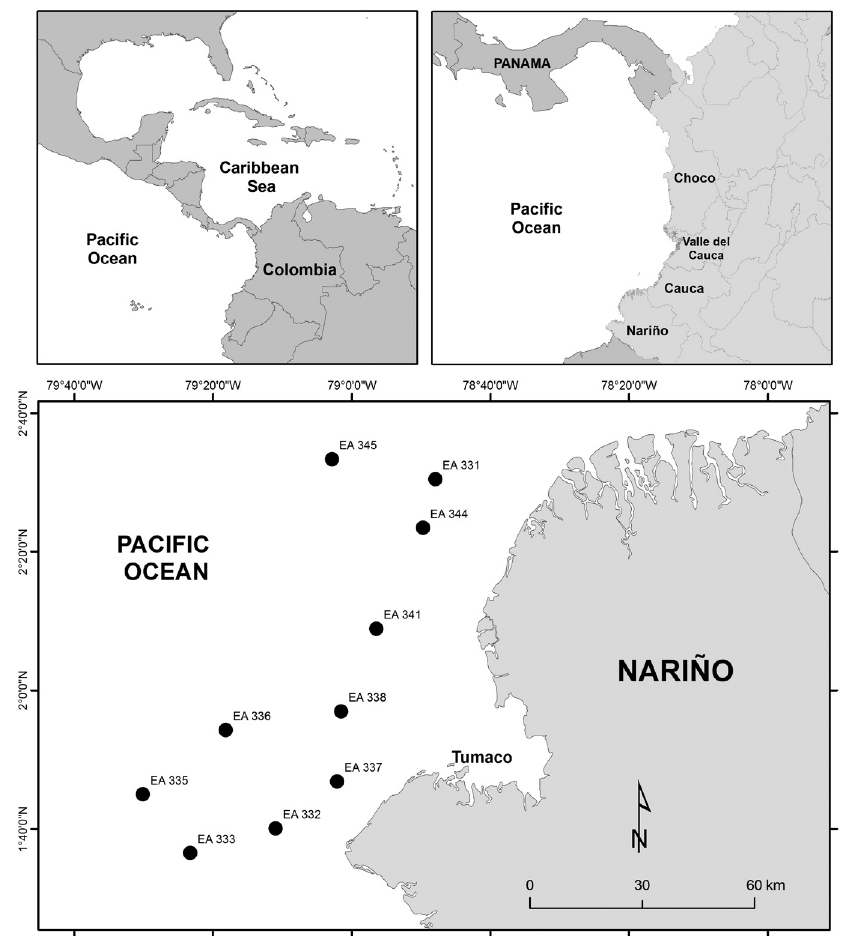
Figure 1. Locations along the Colombian Pacific Ocean where bivalves were